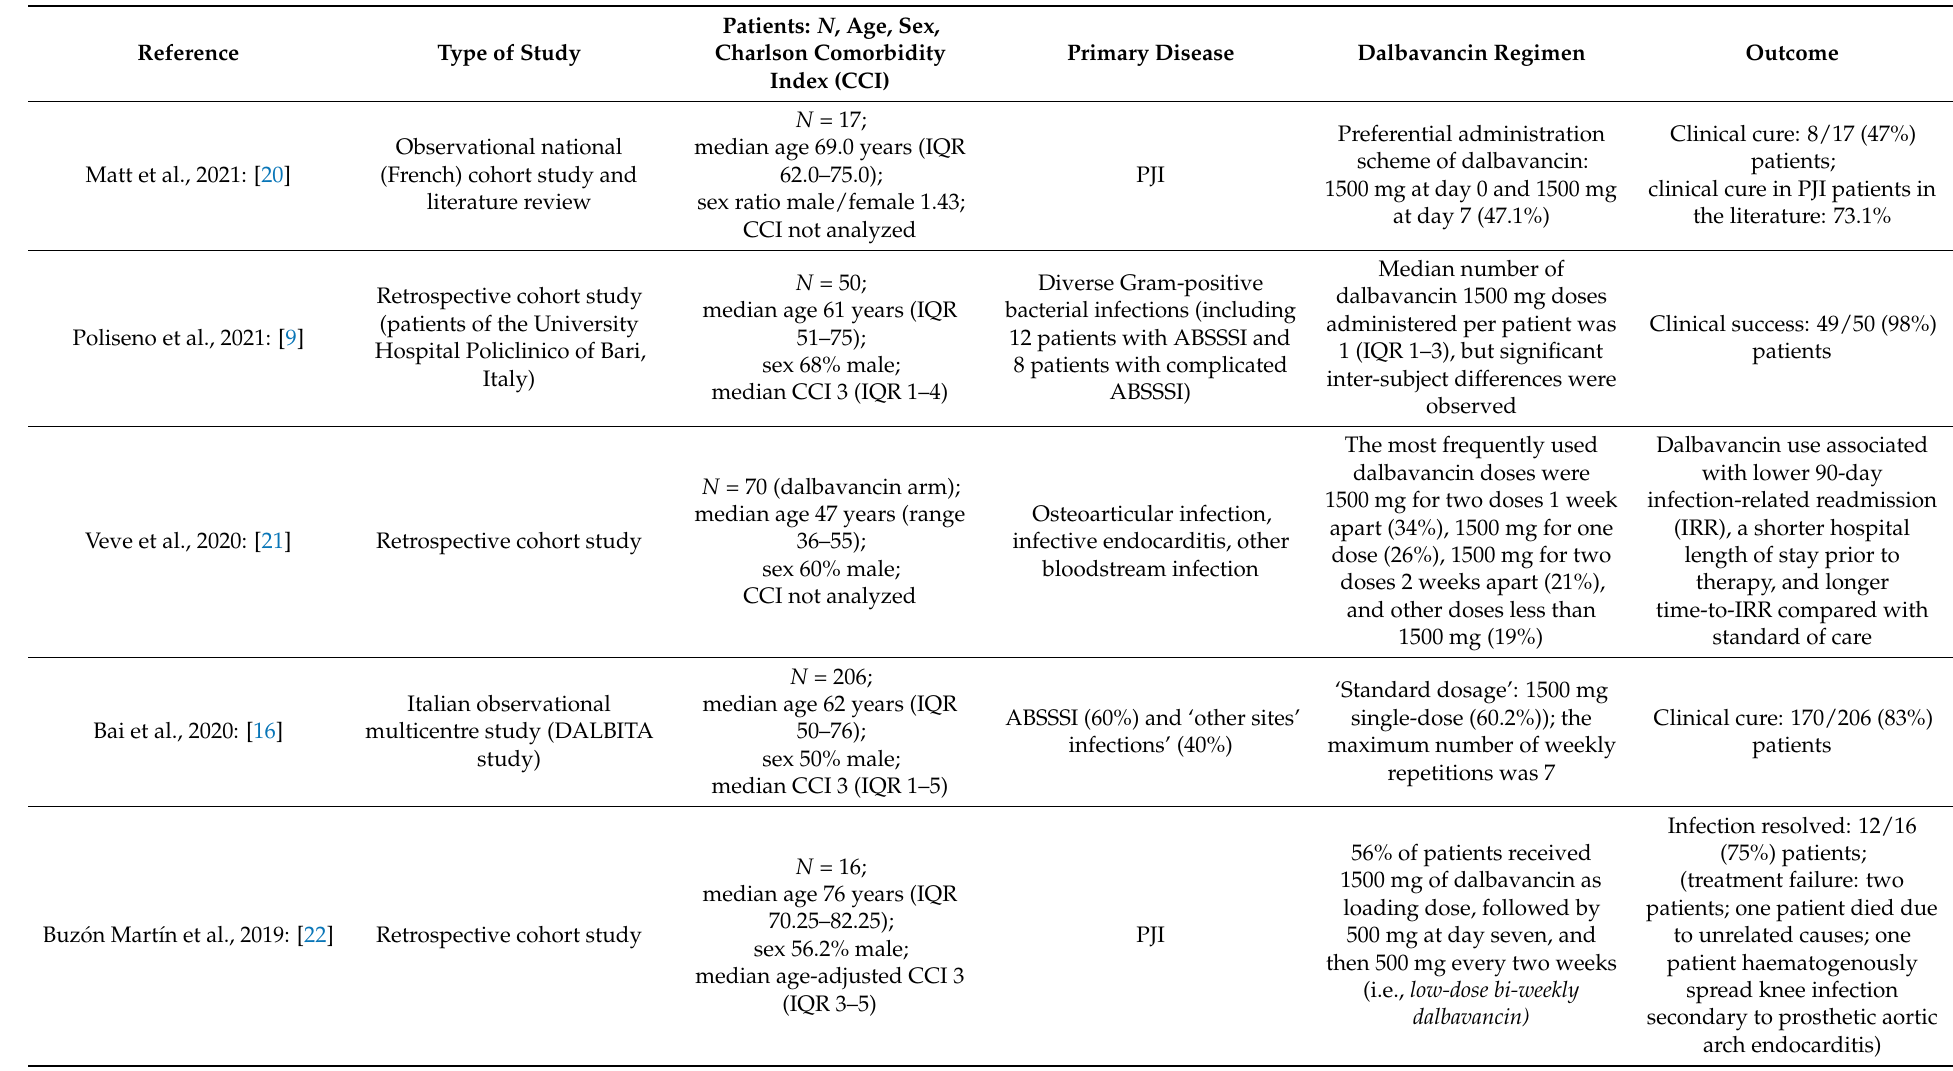
Table 4. Previous studies on